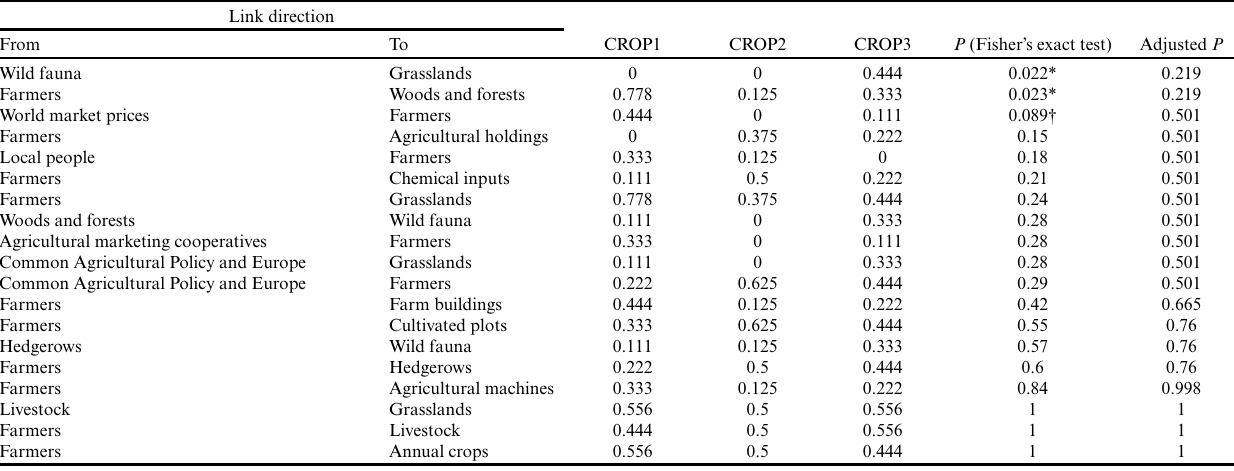
Table 5. Links tested during comparative analysis of farmer groups based on types of cropland management practices (typology 1). Link direction